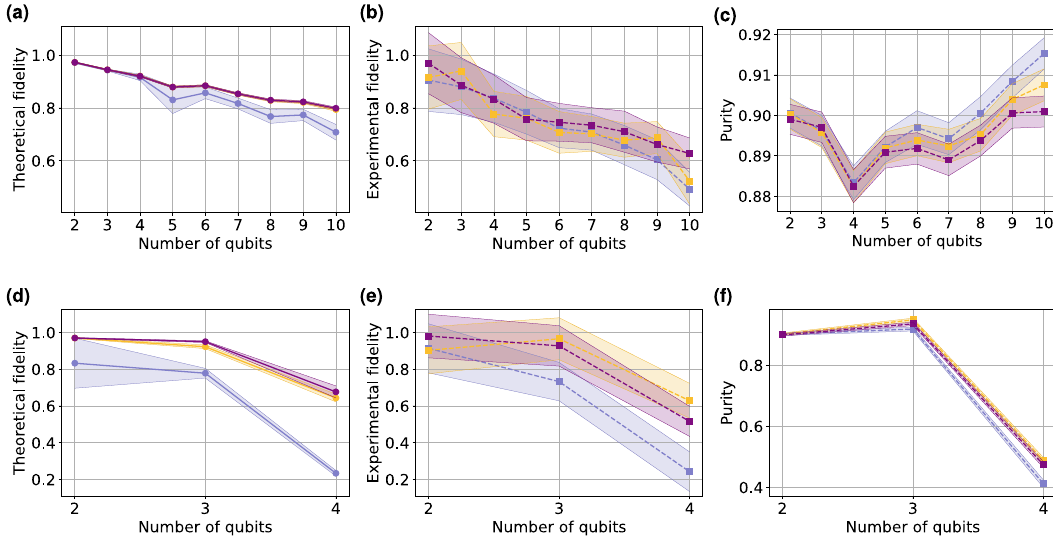
(cid:2) (cid:4) (cid:2) as a function of the number of qubits. 3